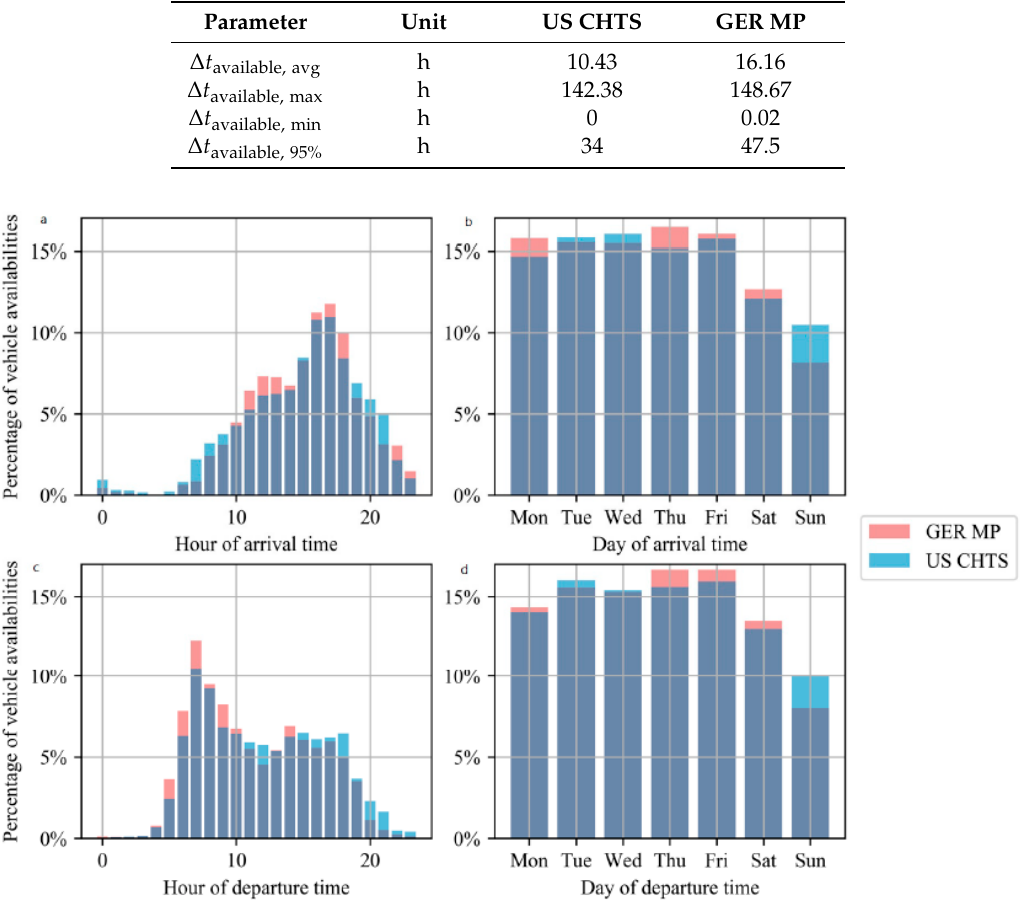
Figure 6. Percentage of vehicle availabilities over ( a ) hour, ( b ) day of arrival time, ( c ) hour, and ( d ) day of departure time.